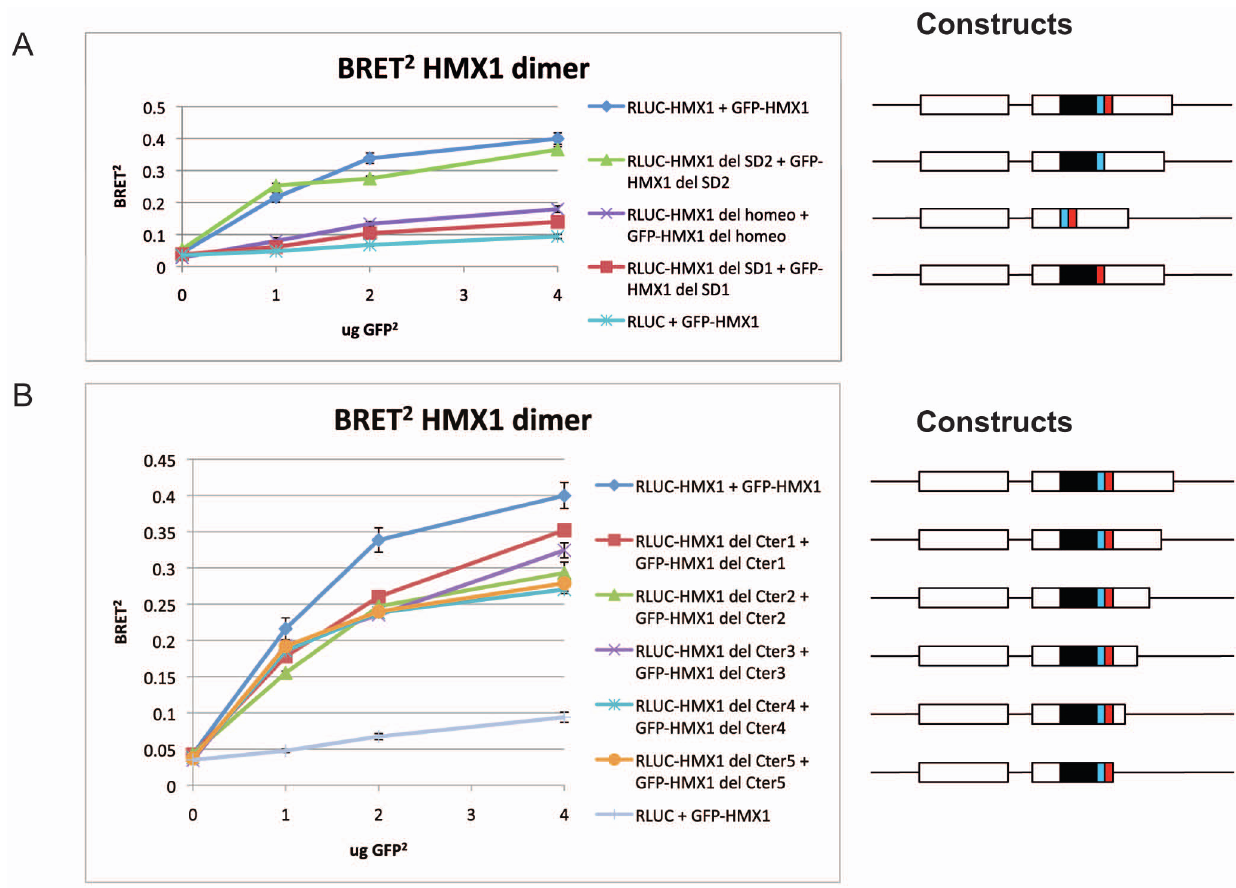
Figure 2. Identification of the domains of HMX1 needed for dimerization. Deletions of two of the conserved domains, the homeobox (black) and SD1 (blue) prevented dimerization. Deletion of the SD2 domain (red) had no effect (A). Deletion of the C-terminus of the protein does not prevent dimerization (B). Data points represent the mean of two experiments + / 2 SD.